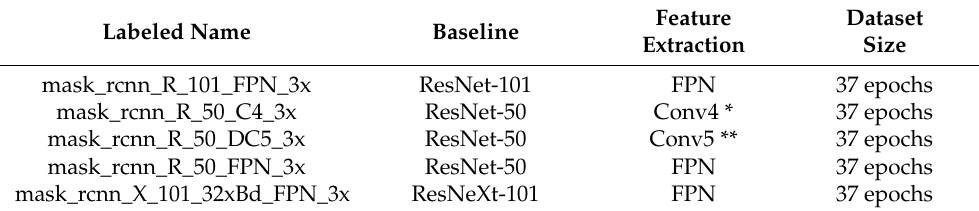
Table 5. Different types of backbone network.